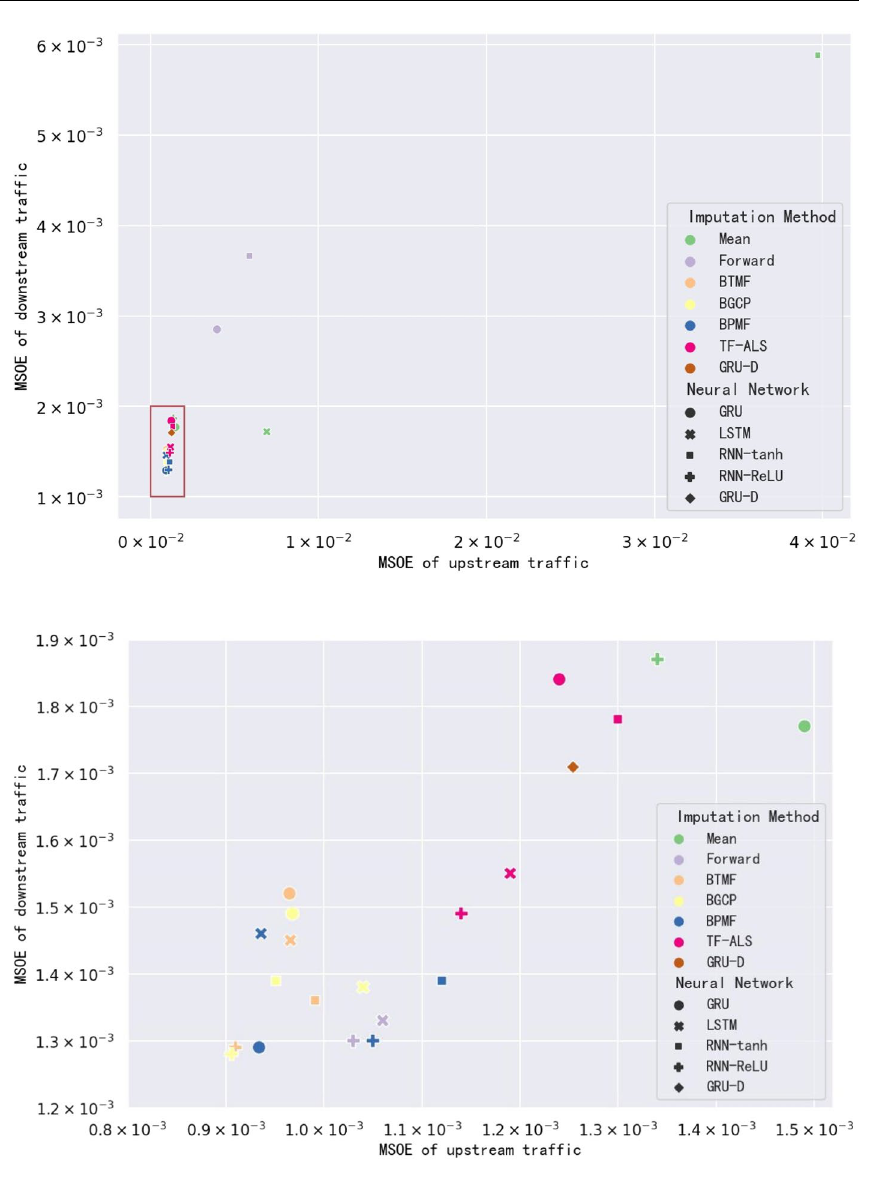
Fig. 10 Overall diagram of model comparison experiment results